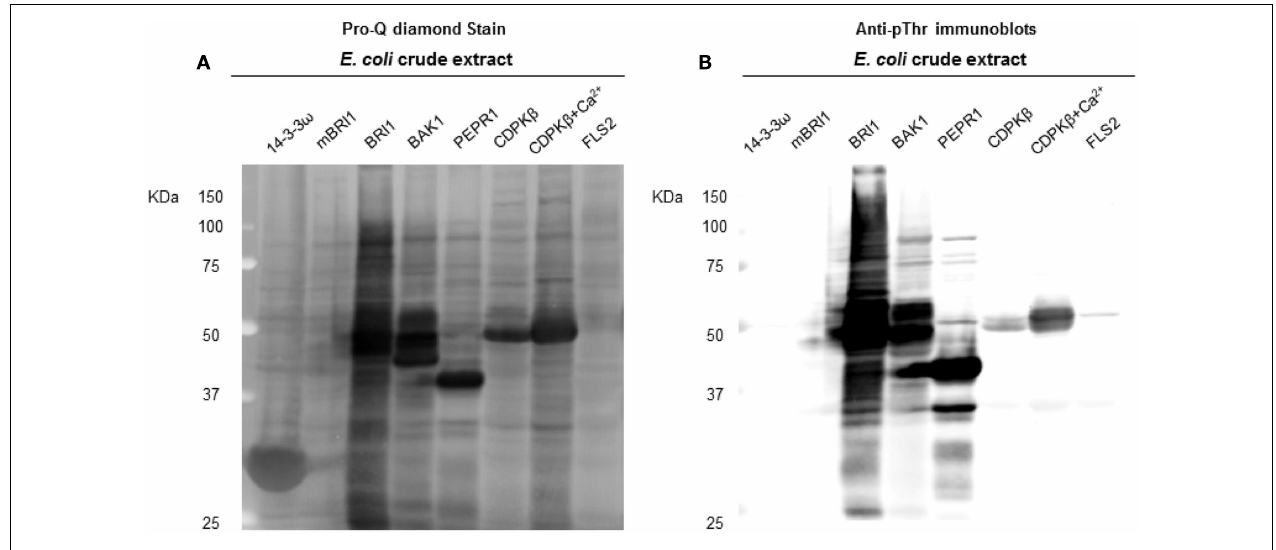
used as controls. In addition to RLK RD kinases (BRI1, BAK1, and PEPR1), kinase CDPK β was also found with considerable increase in E. coli phosphorylation, when a 1mM Ca 2 + was added to E. coli growth culture. (B) Anti-pThr immunoblots confirmed the phospho bands identified by